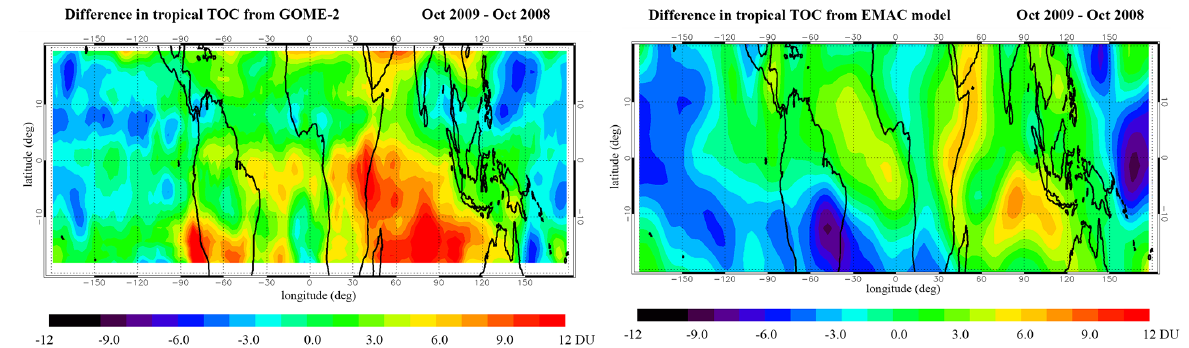
Figure 9. Difference between the tropical TOC in October 2009 and 2008: (left) difference in the TOC derived with the GOME-2/CCD method and (right) difference in the TOC calculated with the EMAC model.